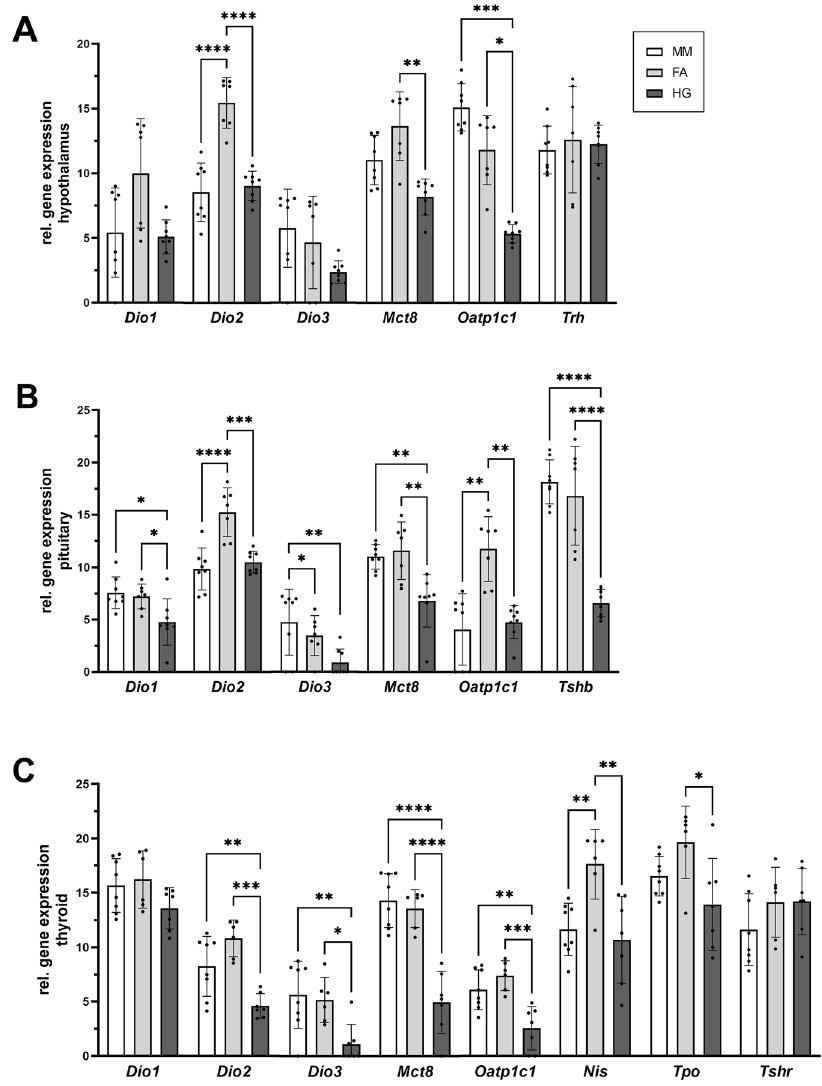
Figure 4. Comparison of gene expression levels on HPT-axis of mice, Ansell’s mole-rats, and naked mole- rats. ( A ) Gene expression levels in hypothalamus, ( B ) pituitary, and ( C ) thyroid gland. Target gene expression levels are expressed as arbitrary units based on Ct levels normalised to 100 pg cDNA (see Eq. 2 and Electronic supplementary material) for comparison across species. Normal distributed data were compared with one- way ANOVA followed by Tukey correction. Not normally distributed data were analysed with Kruskal–Wallis test followed by Dunn’s multiple comparisons test when normal distribution was not achieved by log- transformation. Statistical significance was set at the level of p < 0.05 (*), p < 0.01 (**), p < 0.001 (***), p < 0.0001 (****). Data are presented as mean ± SD. MM, Mus musculus ; FA, Fukomys anselli ; HG, Heterocephalus glaber